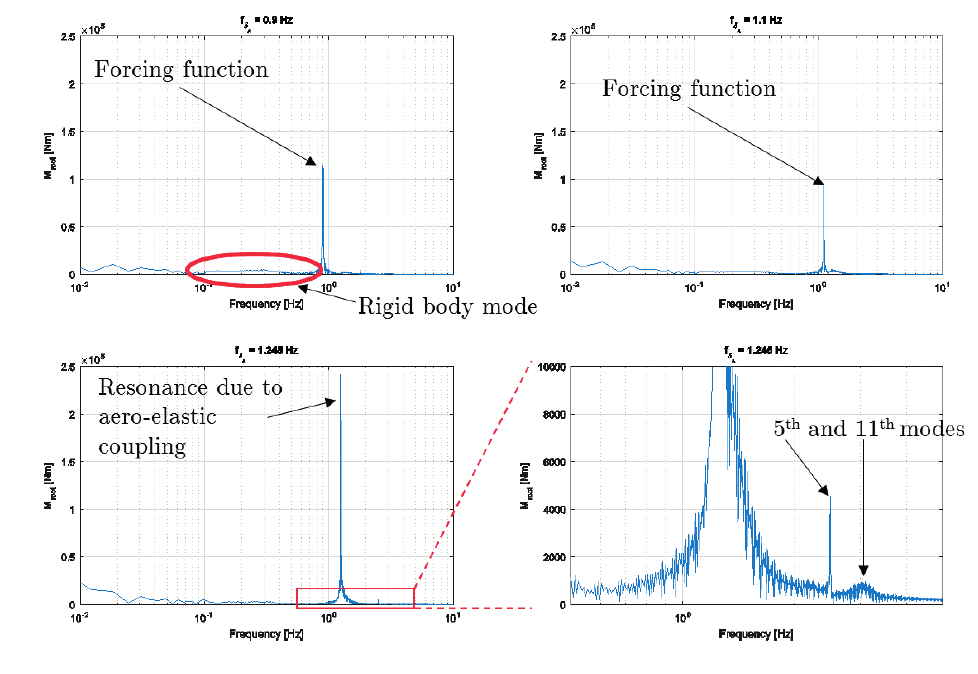
Fig. 13. Wing root bending moment M root at different aileron excitation